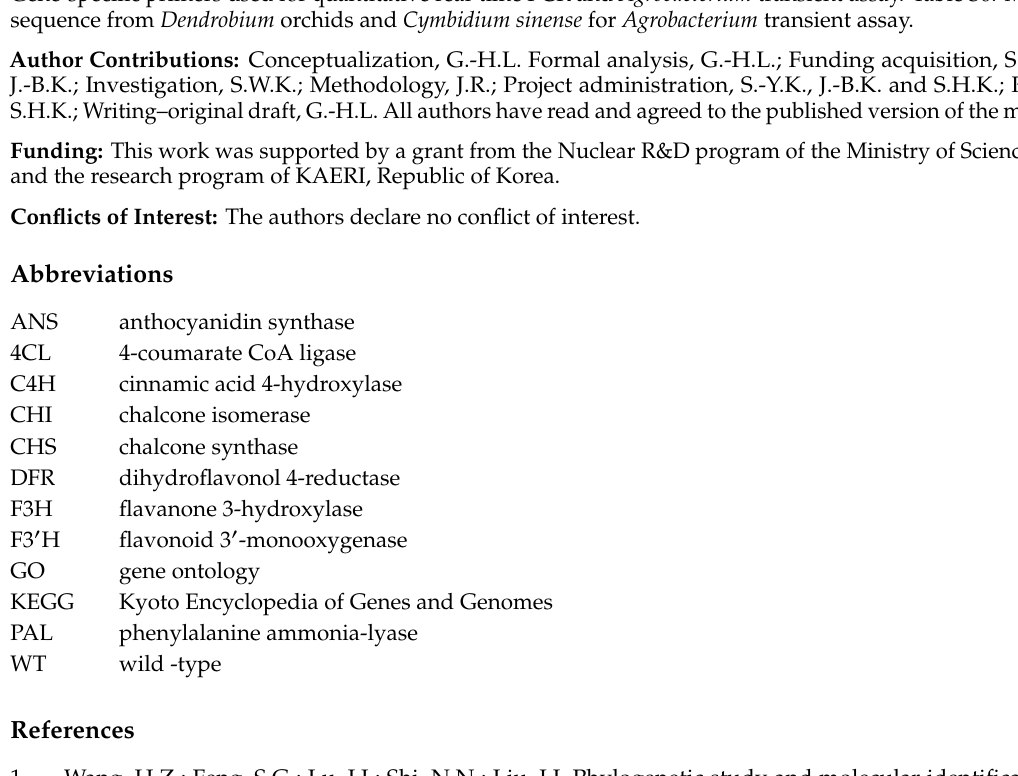
biological process, cellular component, and molecular function. The x -axis indicates the subcategories and the y -axis indicates the number of unigenes in each category. Figure S3. Numeric distribution of eggNOG annotations of unigenes. Letters on the x -axis refer to the categories on the right. The y -axis indicates the number of unigenes in the corresponding eggNOG category. Figure S4. Distribution of annotated sequences as assessed using a Kyoto Encyclopedia of Genes and Genomes (KEGG) pathway analysis. The x -axis indicates enriched KEGG pathways, and the y -axis represents the number of unigenes within each KEGG pathway. (A) Metabolism; (B) genetic Table S1. Significantly enriched GO terms. Table S2: Significantly enriched KEGG pathways. Table S3: Clusters of annotated GO terms in the biological process category enriched in up- and downregulated genes between WT and the RB016-S7 leaves. Table S4: Expression profiles of the regulatory genes for leaf color in D. bigibbum . Table S5: Gene-specific primers used for quantitative real-time PCR and Agrobacterium transient assay. Table S6: MYB2 gene sequence from Dendrobium orchids and Cymbidium sinense for Agrobacterium transient